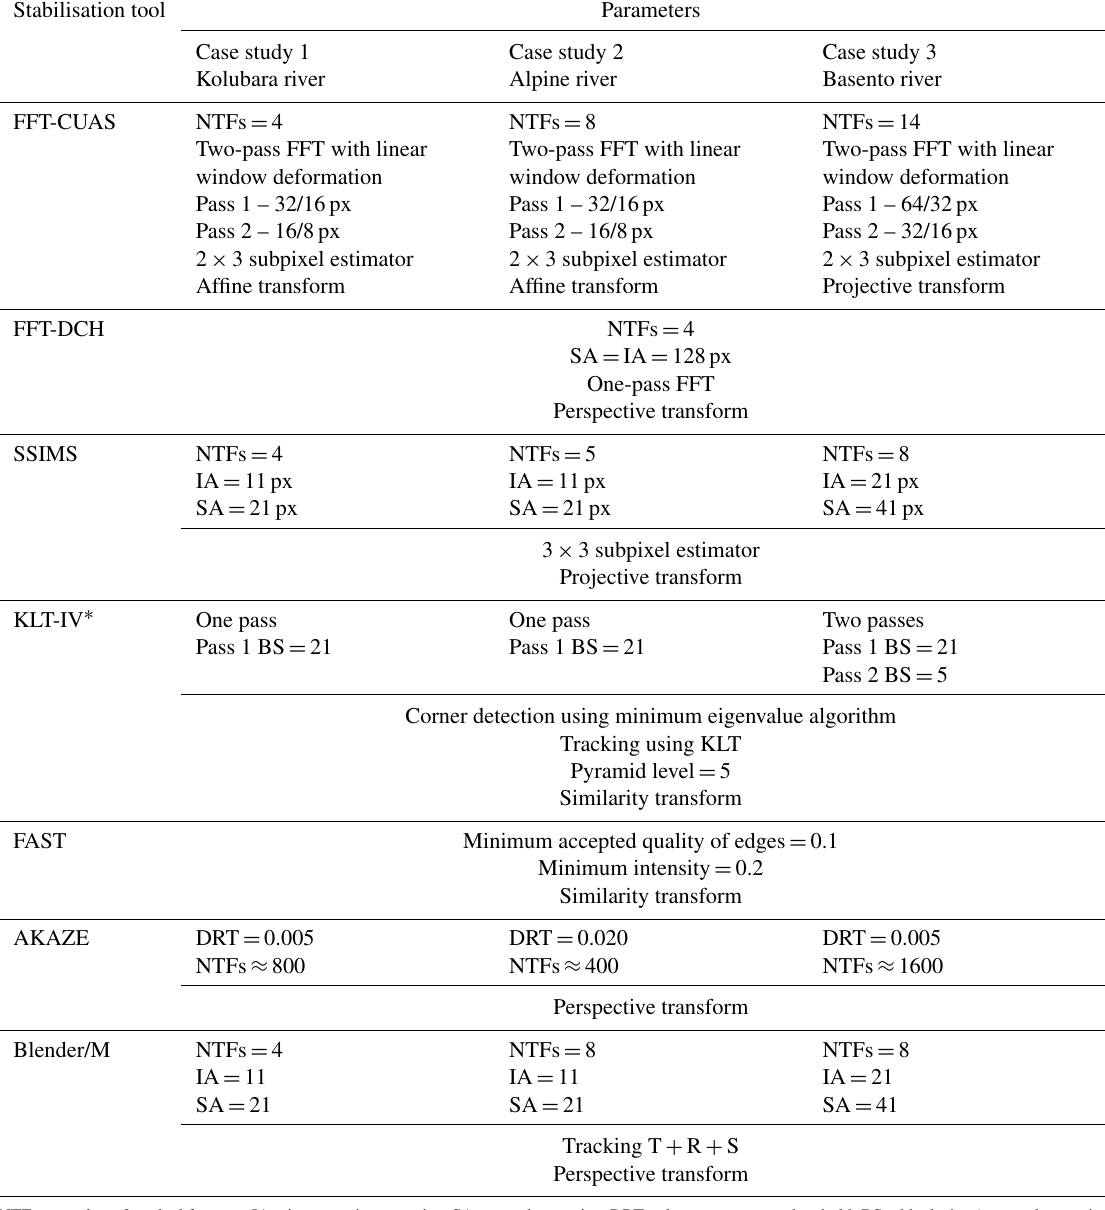
Table A1. Feature detection and tracking parameters used for the three case